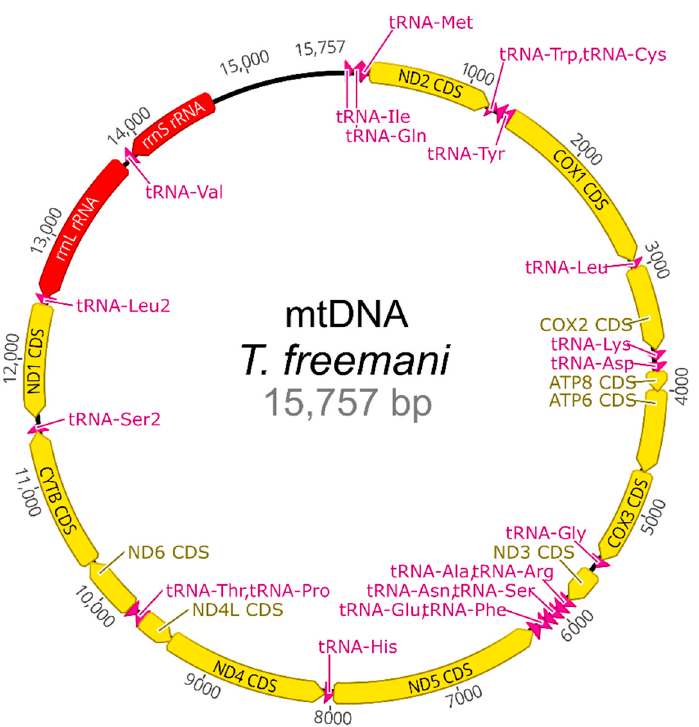
Figure 9. Circular map of the mitochondrial genome of T. freemani . Genes are labeled by standard abbreviations, and the direction of gene transcription is indicated by arrow orientation. Protein- coding genes are shown in yellow, ribosomal RNA genes in red, transfer RNA genes in magenta, and the control region in black.